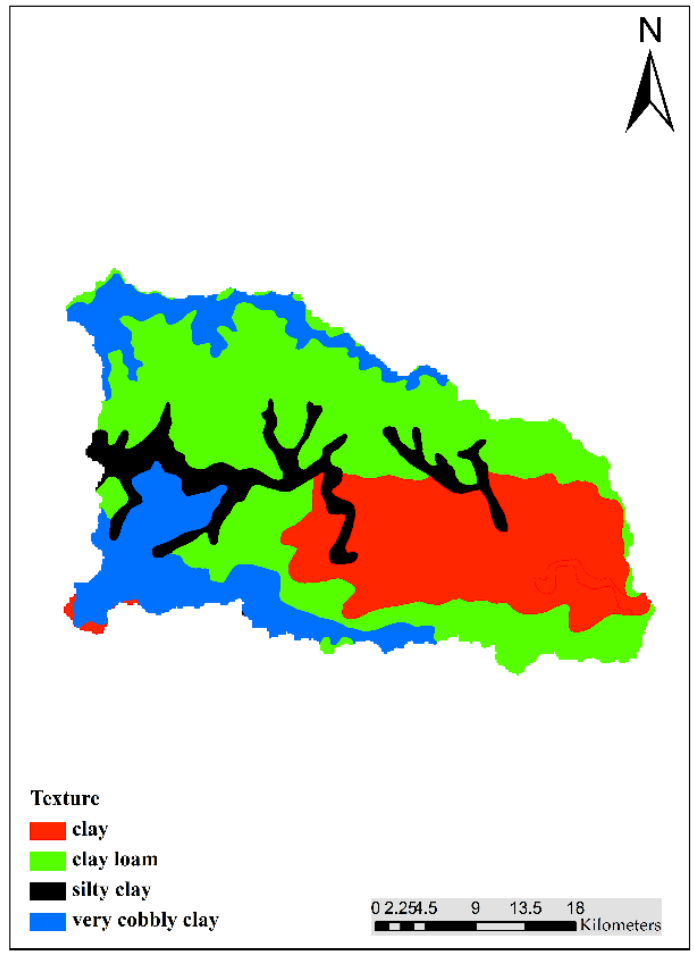
Figure 5. Soil types in the study